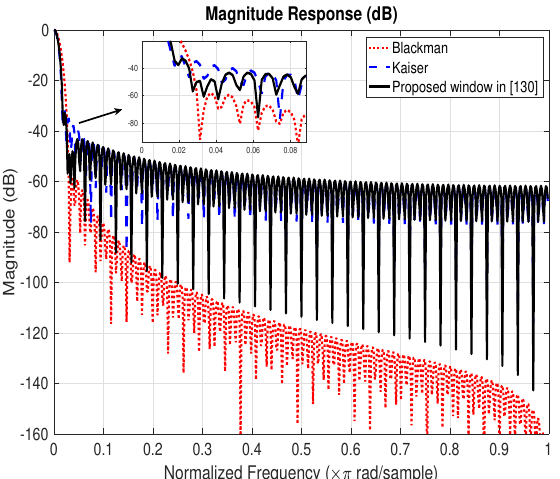
Figure 6. Frequency responses of Blackman window, Kaiser window and the new window by the GWMT